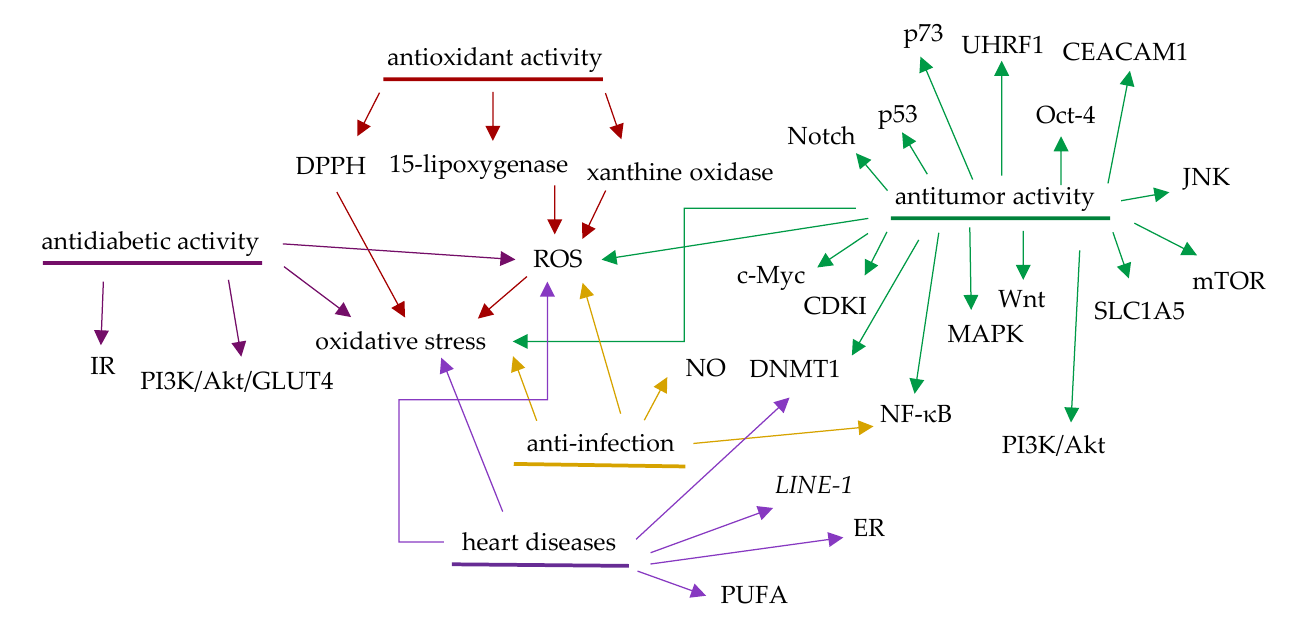
Figure 5. Molecular targets identified for mediation of pharmaceutical properties of Aronia ber- ries.